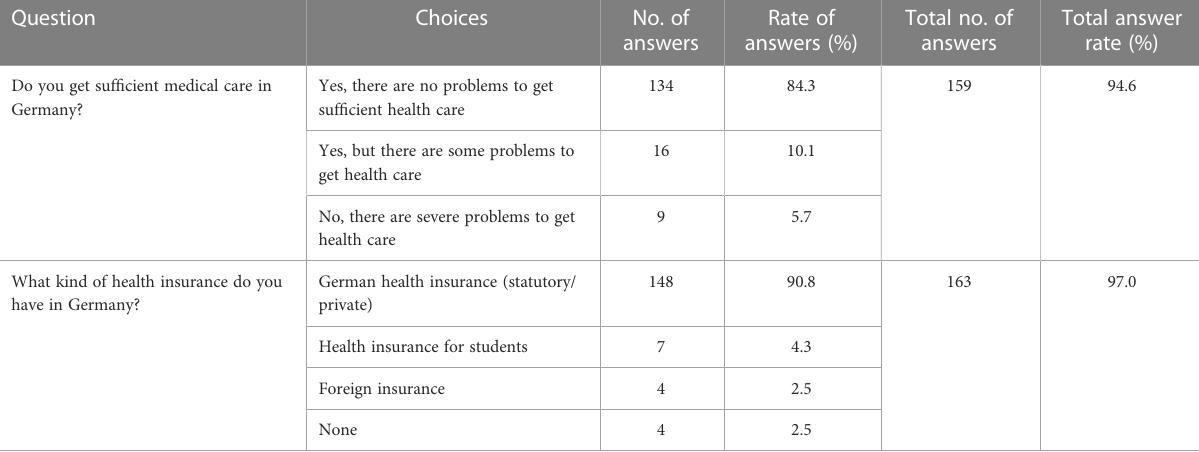
TABLE 6 Access to medical care in Germany.